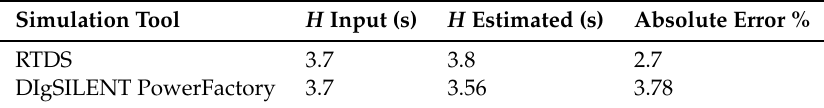
Table 2. Inertia estimation results at bus 1, Case 3 phase short-circuit.